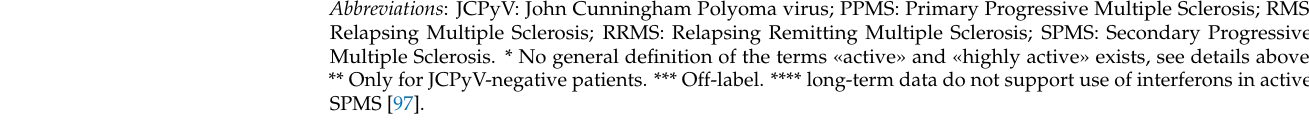
Table 2: MS therapy landscape in Switzerland in 2022 (Alphabetical order, according to marketing approval text [3,11], see details